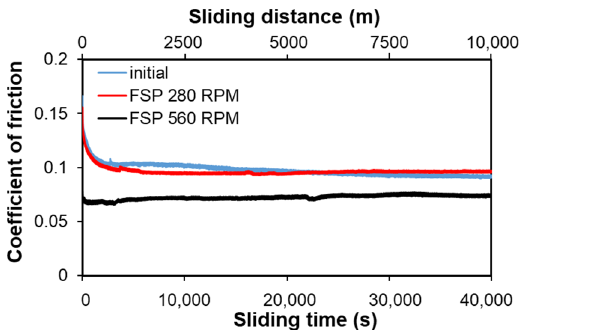
8 of 15 Figure 9. Comparison of flexural strength and fracture morphology of B89 alloy before and after FSP. The flexural strength values obtained as a result of the three-point flexural test (Figure 9) showed an increase in the case of the samples after FSP modification with a pin rotational speed of 280 RPM (307 MPa) compared to the alloy in the initial state, for which the flexural strength value was 214 MPa. The rise in flexural strength in the case of the B89 alloy after FSP modification with the speed of 280 RPM is caused by refinement of and a change in the morphology of the Cu 6 Sn 5 phase particles to a more globular shape. Due to the significant pin action impact in the processed material and the dynamic flow of the material in its action impact zone, the stir zone is characterized by the presence of various stress states [28]. The direction of rotation and travel of the pin are the same on the ad- vancing side, while on the retreating side they already show the opposite direction, which also generates an additional temperature gradient in the process zones. This causes the generation of additional stresses in the advancing zone in relation to the retreating side in the modified material [29,30]. Such a phenomenon significantly affects the susceptibility to cracking, as exemplified by the material modified with the pin rotational speed of 560 RPM, in which the strong pin action impact generated significant stresses, resulting in a significant reduction in flexural strength in the transition zone (123 MPa). 3.3. Tribological Properties Figures 10–14 below show the results of tests of the tribological properties of the B89